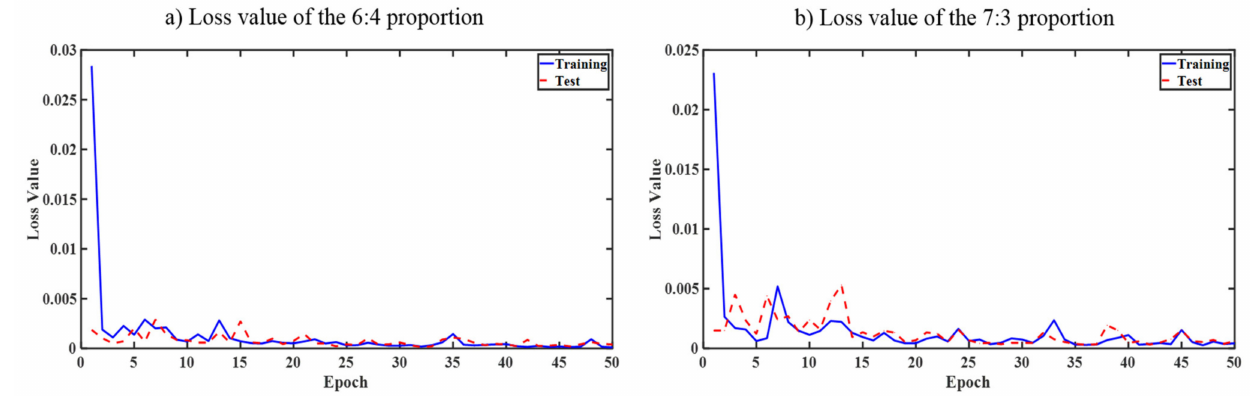
Figure 10. Loss curve of the different